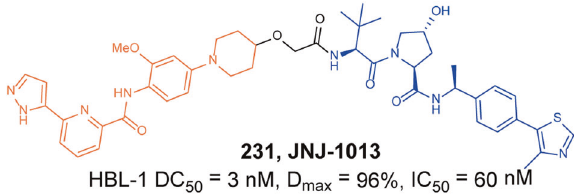
Fig. 77 The representative PROTAC targeting IRAK1